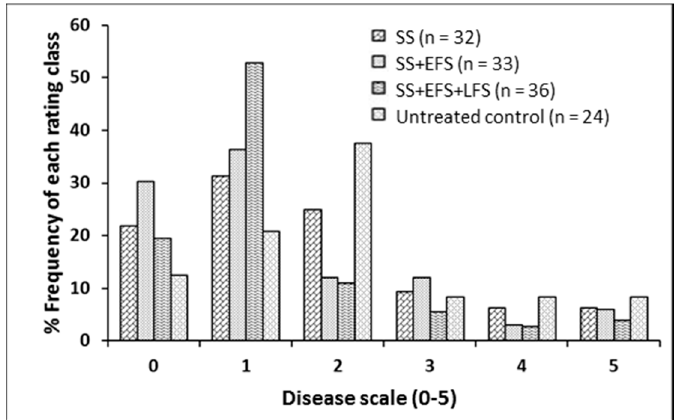
Figure 4. Frequency of plants of the canola hybrid “1950RR” rated 0–5 on a blackleg disease severity scale under different fungicide treatment regimes. The treatments consisted of Headline (pyraclostrobin) application at: seedling stage (SS), SS + early flowering stage (EFS), SS + EFS + late flowering stage (LFS), and an untreated control. Plants were rated on a 0–5 scale, where: 0 = no disease in a cross-section of the stem base; 1 = decay on <25% of the cross-sectional area of the crown; 2 = decay on 25%–50% of the cross-section; 3 = decay on 51%–75% of the cross-section; 4 = decay on >75% of the cross section; and 5 = death of the plant [17]. The experiments were conducted at Edmonton (Crop Diversification Centre North; CDCN) in 2014 and 2015, and at Namao, Alberta, in 2014.